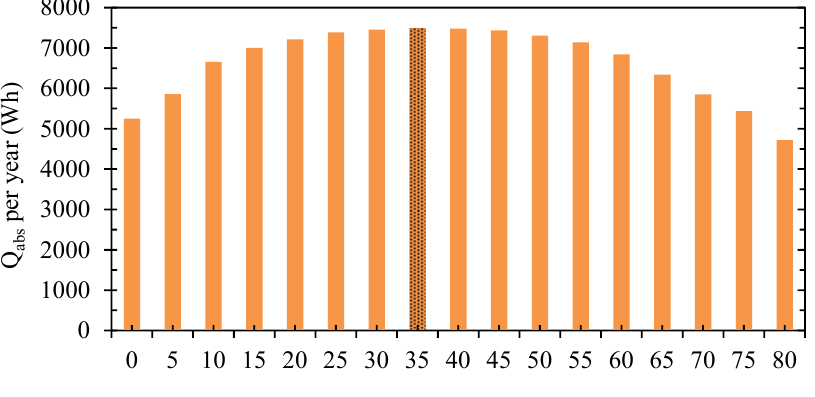
Figure 2. Sum of the energies absorbed in all months at each tilt